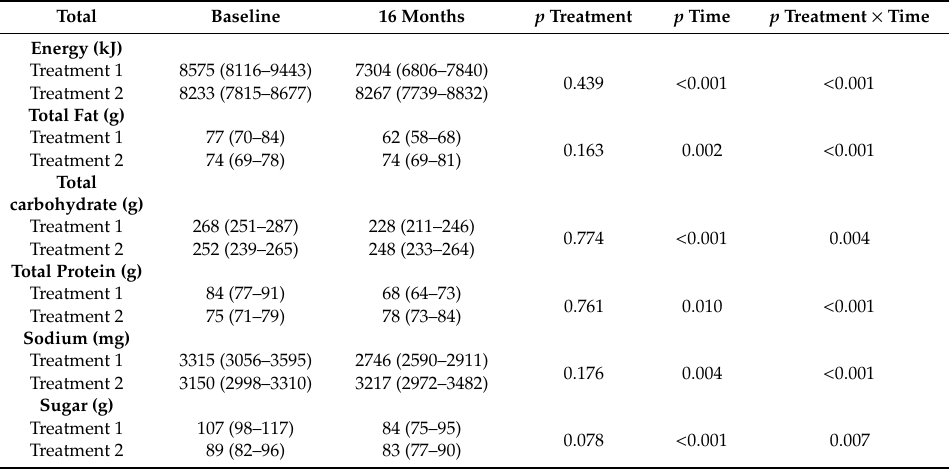
Table 4. Profile of total food intake before and after the intervention (n =